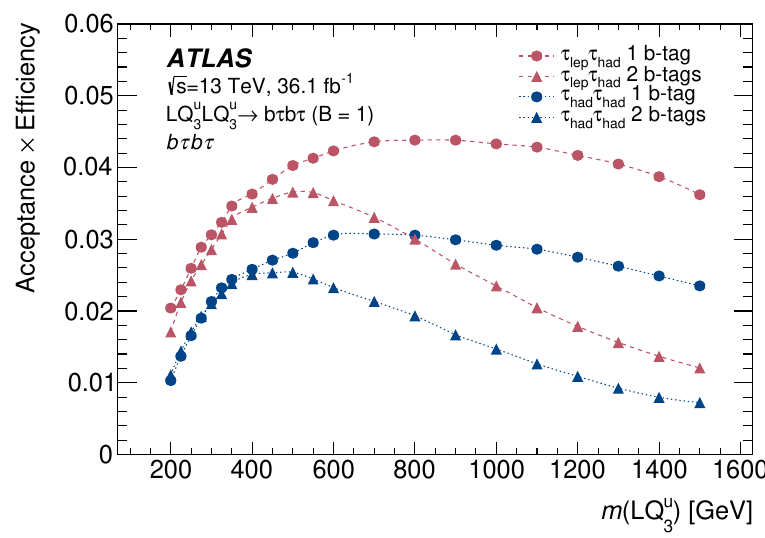
Figure 3 . The acceptance times e(cid:14)ciency for the up-type leptoquark signal is shown for the (cid:28) ‘ (cid:28) had and (cid:28) had (cid:28) had channels as a function of the leptoquark mass. The o(cid:15)ine selection is summarized in table 1. The results are given separately for selected events with one and two b-tagged